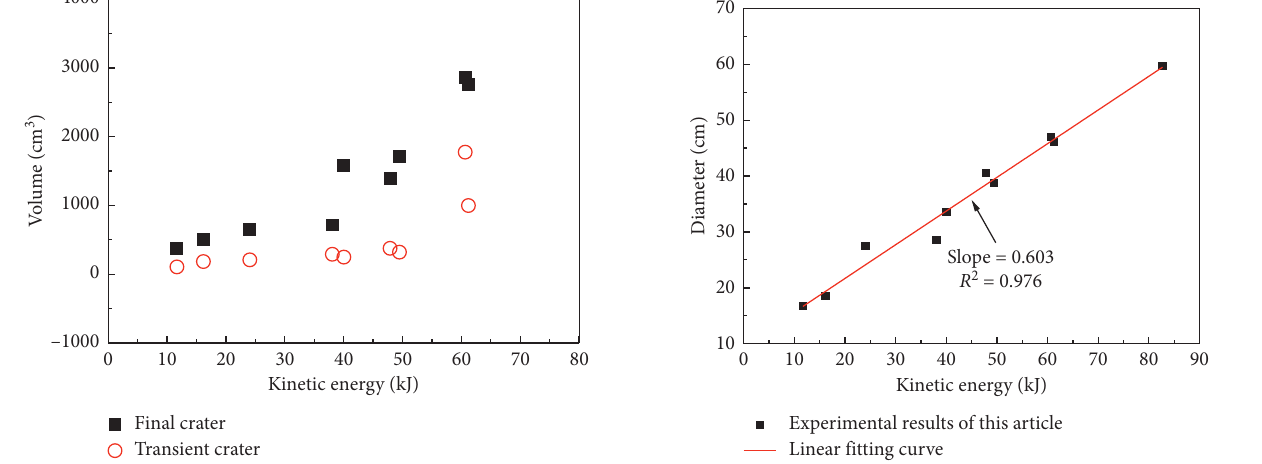
Figure 11: The volumes of the final and transient crater change with the kinetic energy of the projectile.